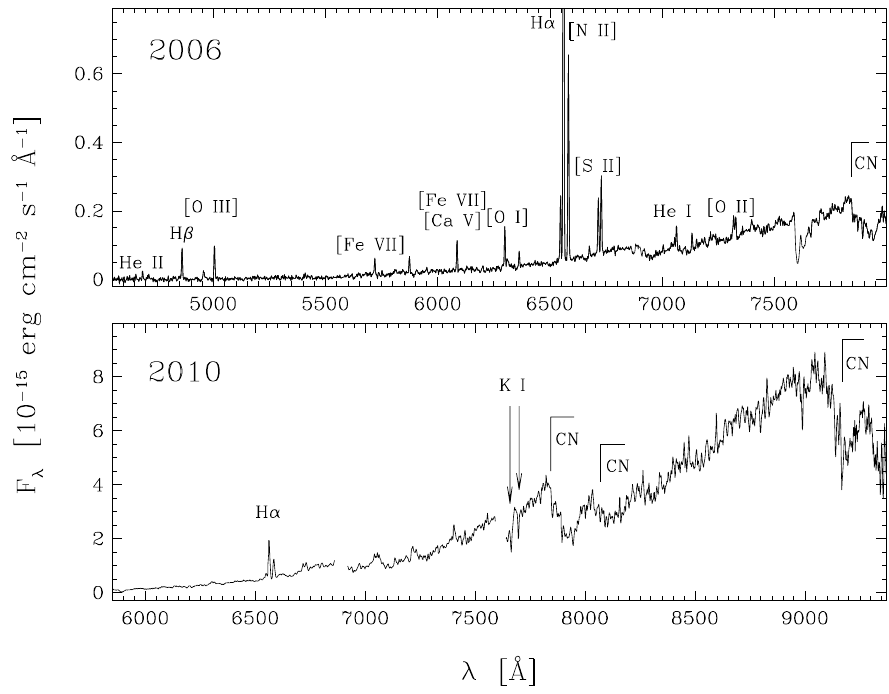
Fig. 4. The 2006 and 2010 spectra of the carbon symbiotic star IPHAS J205836.43+503307.2 ((cid:12)gure adapted from Corradi et al.